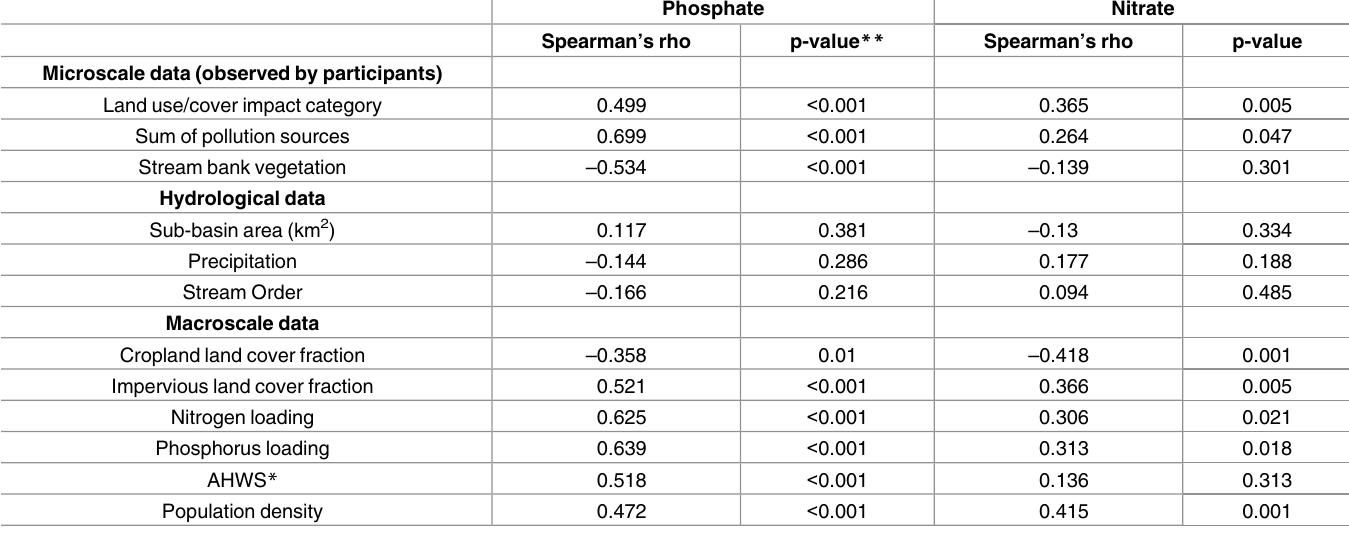
Table 1. Spearman’s rho between sub-basin averagedphosphate and nitrate concentrations (n = 57) and microscale and macroscale variables. * AHWS refers to the Adjusted Human Water Security, [29]. ** Significant p-values, considering multiple hypotheses are below 0.002 (Bonferroni